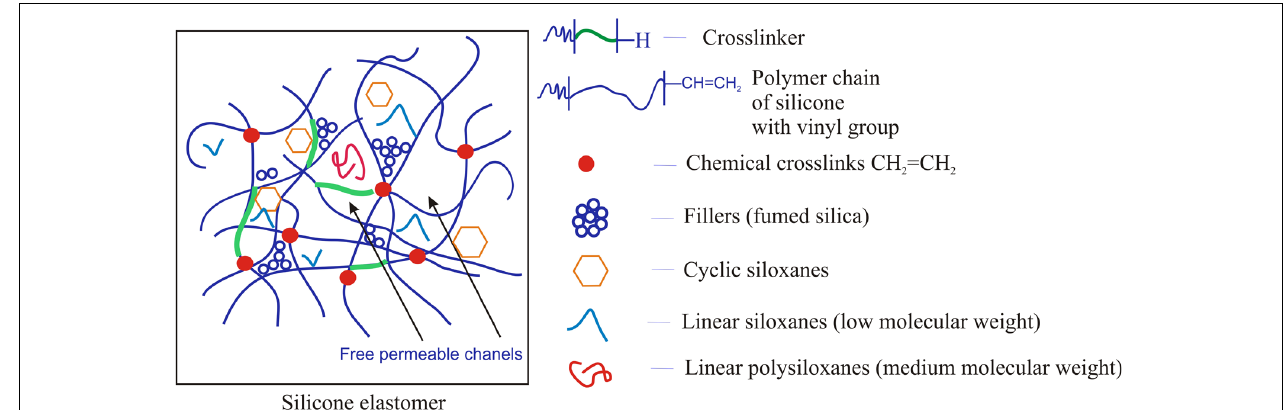
FIGURE 3 | Scheme of short chain siloxanes with a linear and cyclic structure closing in the elastomer network.